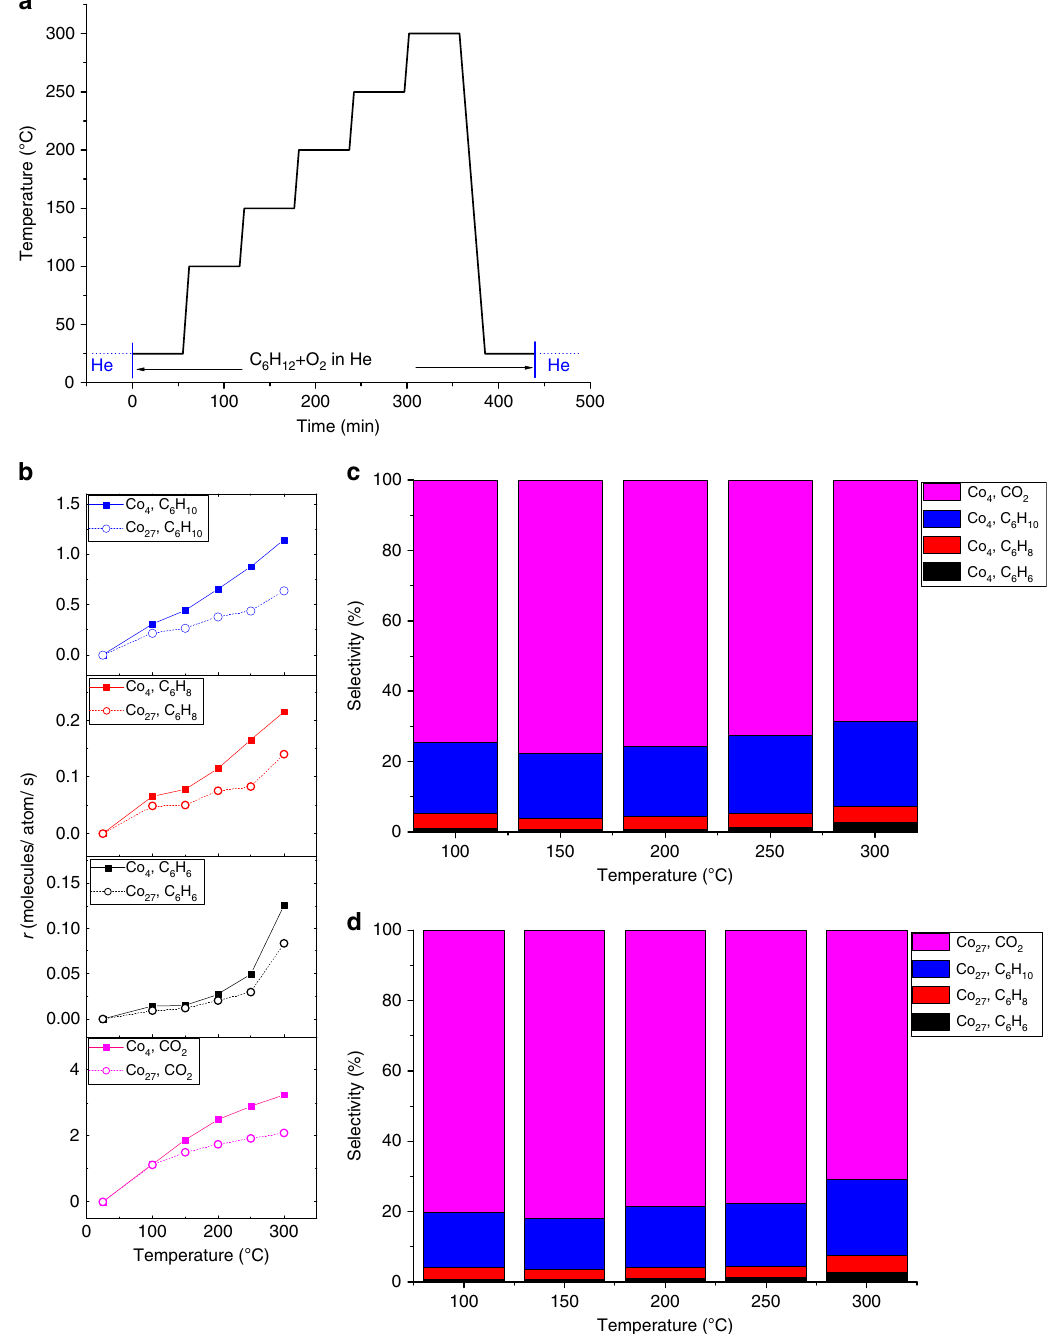
Fig. 2 Performance of alumina-supported Co clusters under oxygen rich conditions (C 6 H 12 :O 2 = 1:10). a Temperature ramp with gas environment applied. b r (rate of formation) for the major products cyclohexene (m/z = 67) on the Co 4 /Al 2 O 3 catalyst (blue squares) and Co 27 /Al 2 O 3 catalyst (blue circles), cyclohexadiene (m/z = 79) on the Co 4 /Al 2 O 3 catalyst (red squares) and Co 27 /Al 2 O 3 catalyst (red circles), and benzene (m/z = 78) on Co 4 /Al 2 O 3 catalyst (black squares) and Co 27 /Al 2 O 3 catalyst (black circles), and the byproduct CO 2 (m/z = 44) on the Co 4 /Al 2 O 3 catalyst (pink squares) and Co 27 / Al 2 O 3 catalyst (pink circles). Cyclohexadiene mass is a superposition from 1,3- and 1,4- cyclohexadiene (both isomers have same electron ionization cross section 53 ). c Carbon-based selectivity for the dominant reaction products with Co 4 /Al 2 O 3 catalyst (blue: cyclohexene, red: cyclohexadiene, black: benzene, pink: CO 2 ), and d Carbon-based selectivity for the dominant reaction products for Co 27 /Al 2 O 3 catalyst (blue: cyclohexene, red: cyclohexadiene, black: benzene, pink: CO 2 ). The interconnecting lines serve as guide to the